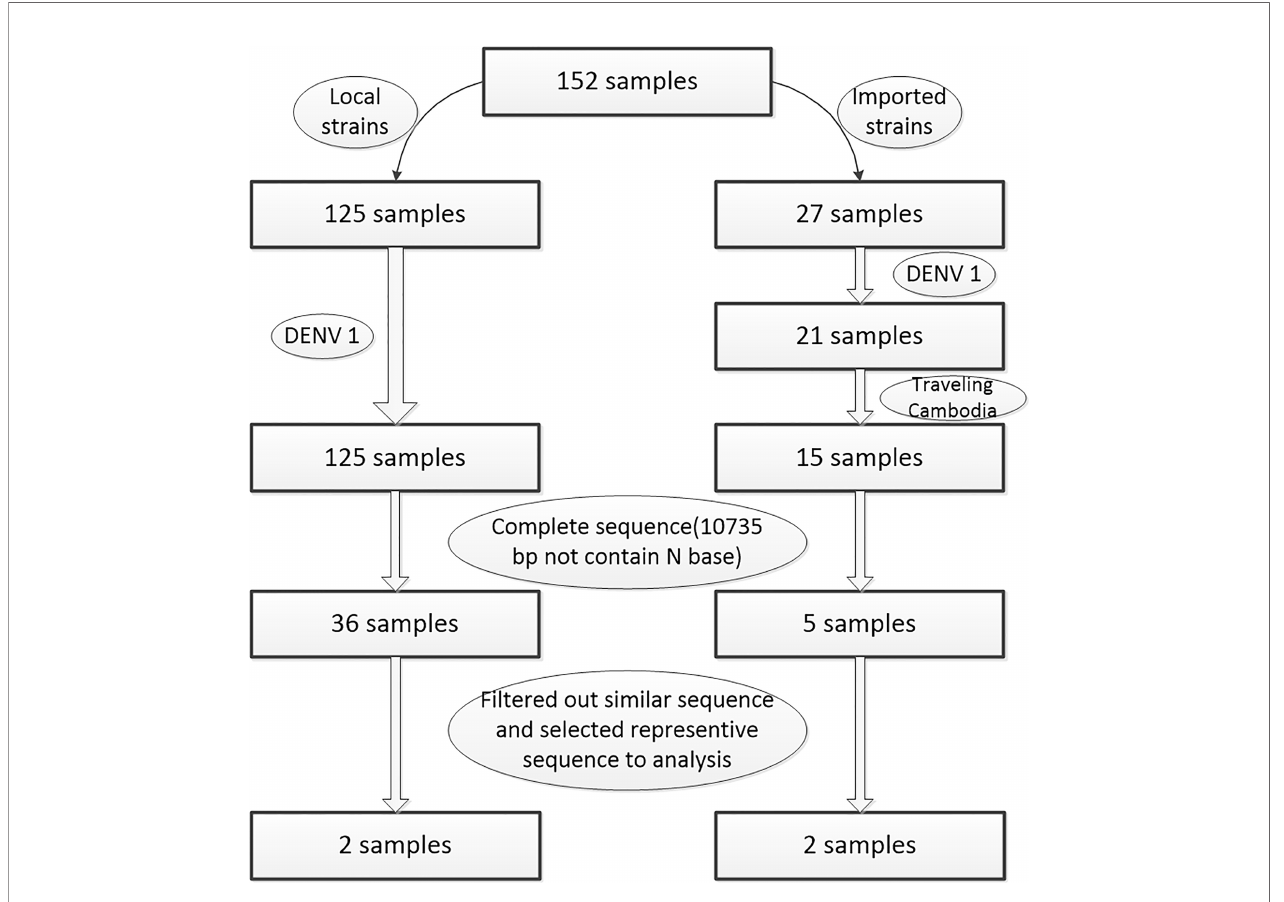
FIGURE 1 | Flowchart of sample fi ltering